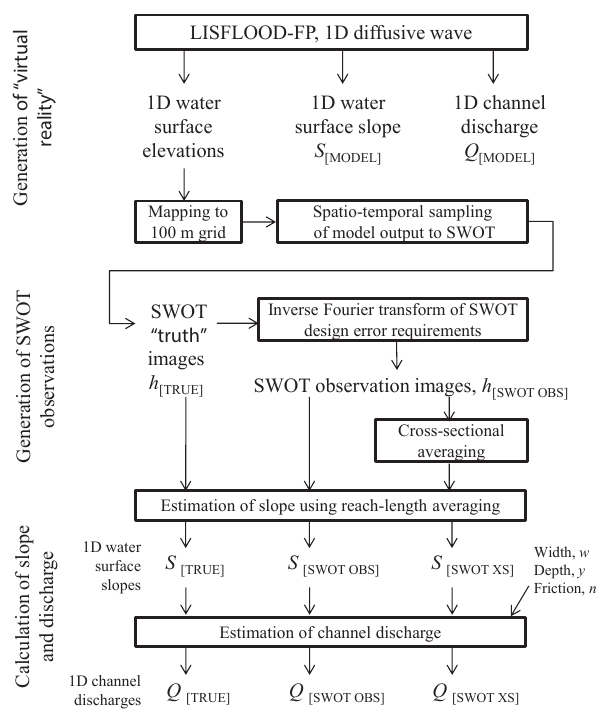
Figure 2. Schematic diagram of the methods used in this